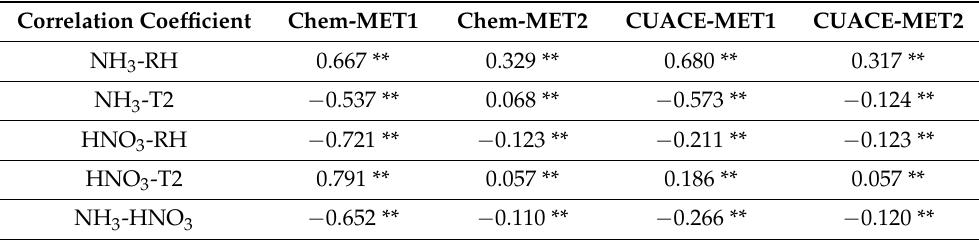
Table 10. Correlation coefficient among ammonia(NH 3 ), nitric acid(HNO 3 ), 2m temperature(T2) and relative humidity(RH) in the four